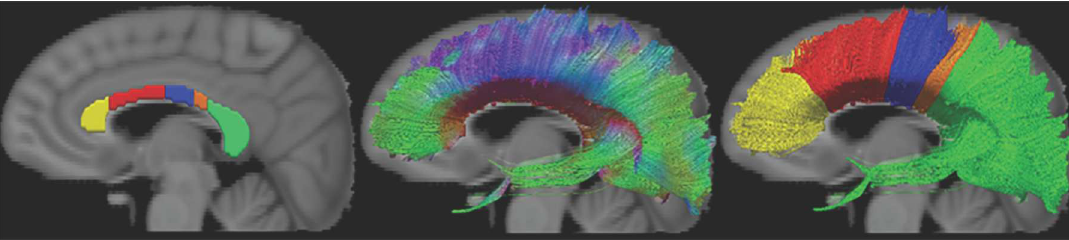
Fig 1. Seed ROIs and example segmentation of the corpus callosum overlaid on an MNI T1-weighted template. The CC was segmentedinto the followingfive regions: CC-I (yellow),CC-II (red), CC-III (blue), CC-IV (orange),and CC-V (green). The middleimage shows a streamline reconstruction of the CC with DEC encodingbased on the primary eigenvector direction. The rightmost image shows the same reconstruction with color determinedby the seed ROI from which the tract